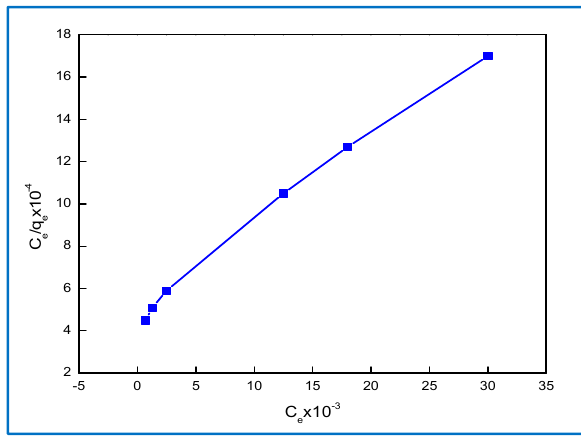
Figure 10. Langmuir adsorption for 20 mg · L − 1 BG dye removal on 0.9 g · L − 1 Hap/CS.